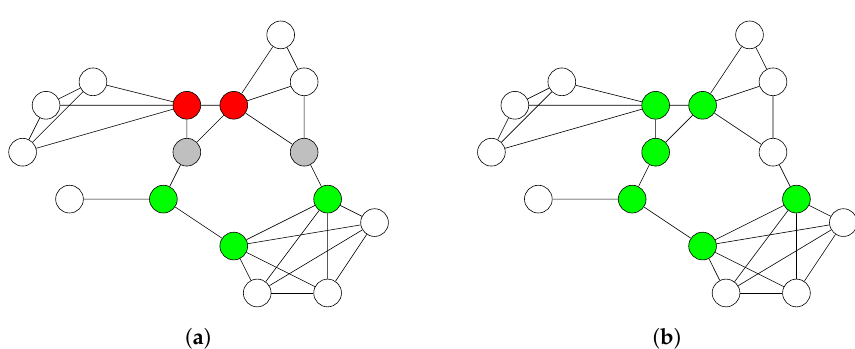
Figure 9. Dominating set being turned into a connected dominating set. The dominators are colored in green and red. The red dominators have a lower token value than the green dominators. White and grey nodes are non-dominators. Furthermore, the grey nodes separate the two disconnected sets of dominators. ( a ) The red dominators periodically receive the token with the largest value from the grey nodes, but do not update their token value because the grey nodes are not dominators. After receiving the token with the largest value from the grey nodes n times, the red dominators elect one of the grey nodes to become a dominator. When one of the grey nodes becomes a dominator, the red dominators accept the token with the largest value from it. ( b ) All dominators have the highest token value and thus are colored in green.